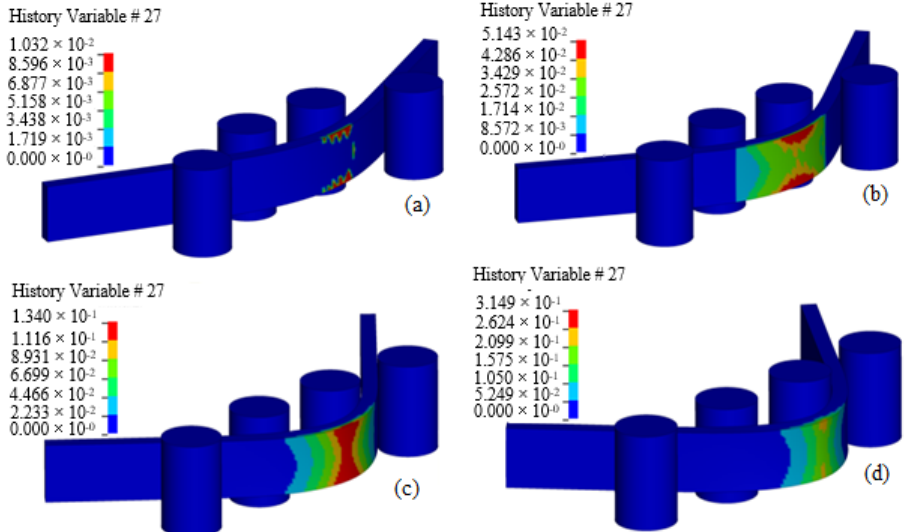
Figure 17. Evolution of damage with the addition of DIEM damage formulation to SAMP-1 material law at different indenter displacements: ( a ) 7.7 mm, ( b ) 10 mm, ( c ) 13.8 mm, and ( d ) 16.7 mm.